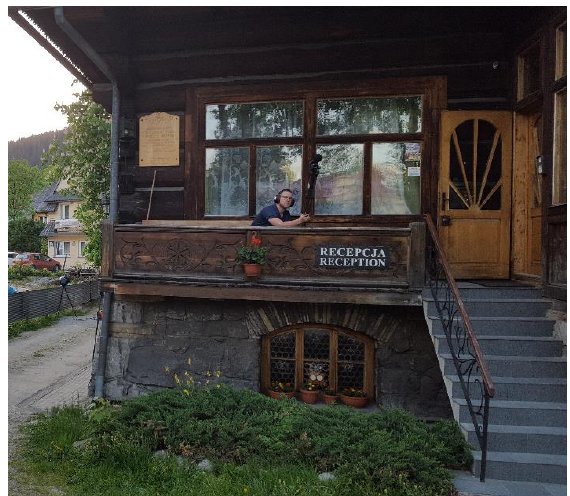
Figure 9. Location of measurement point in front of the building (2 m from the façade and 4 m above the ground)